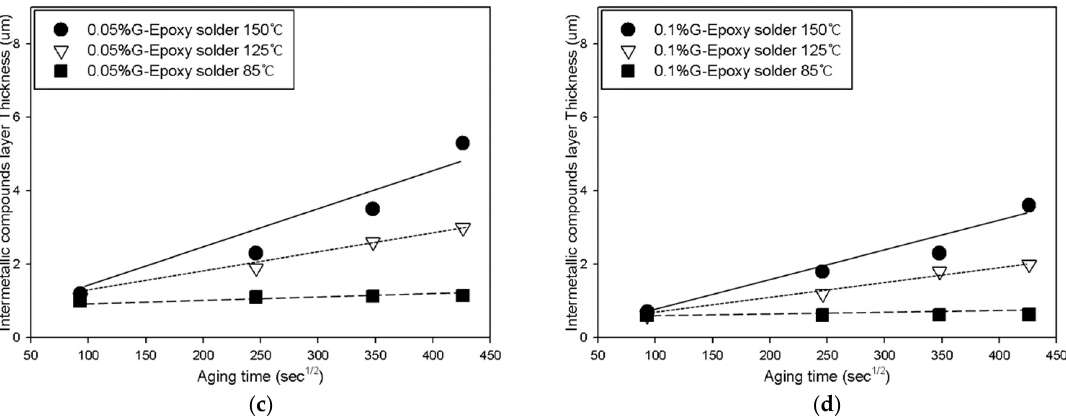
Figure 5. IMC layer growth over time in the solder joints: ( a ) plain solder joint; ( b ) 0.01%-GNS solder joint; ( c ) 0.05%-GNS solder joint; ( d ) IMC thickness in the 0.1%-GNS solder joint.